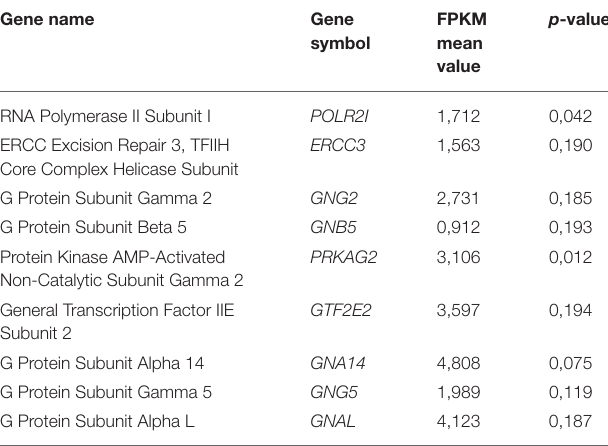
TABLE 2 | “Androgen Signaling” pathway annotations—granulosa cells from primary follicles.